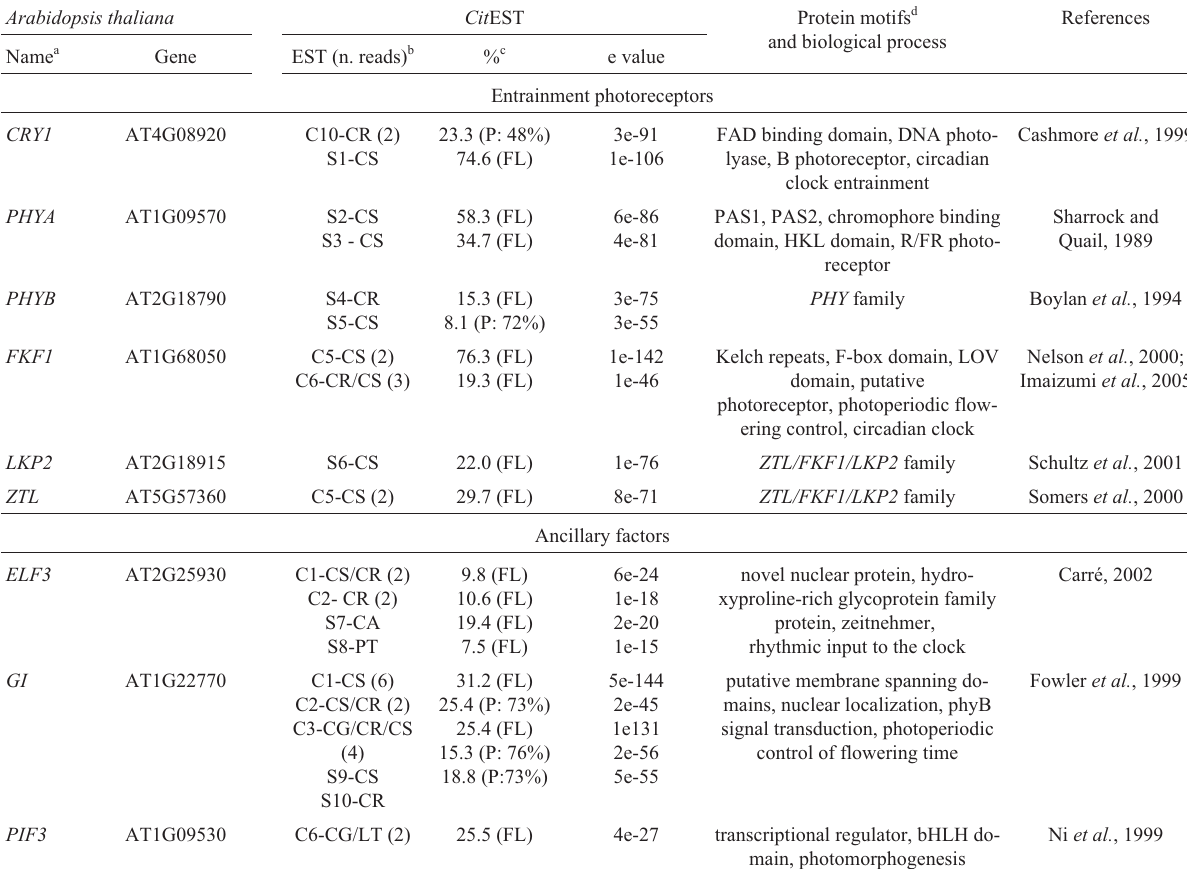
Table 1 - Citrus ESTs with homology to genes involved in the input pathway to the circadian clock in Arabidopsis thaliana . Arabidopsis thaliana Cit EST Protein motifs